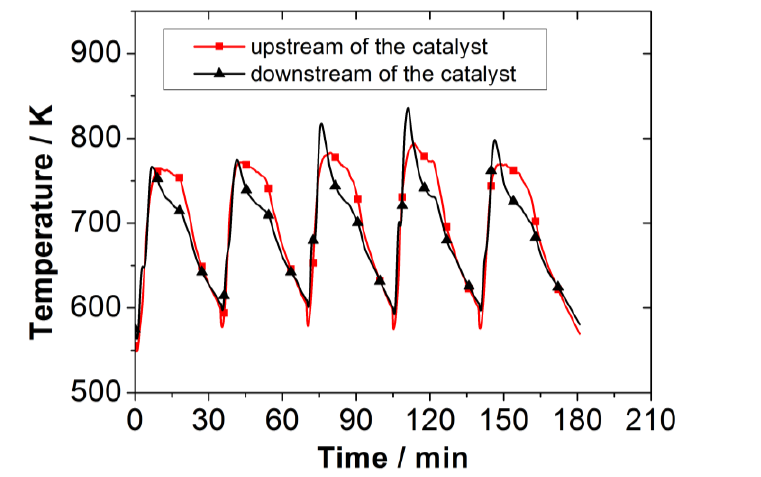
Figure 3. Temperature upstream and downstream of the catalyst during several burning cycles in the wood log stove.